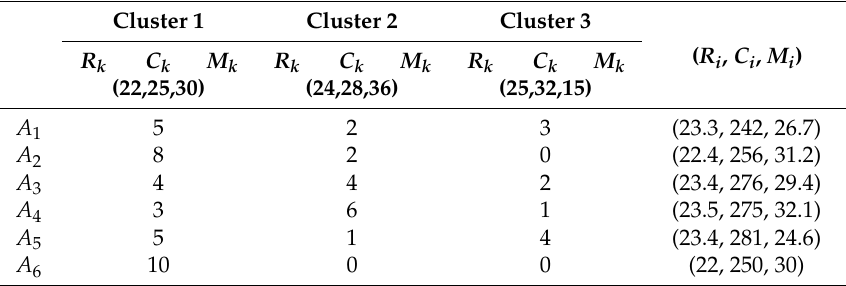
Table 2. Example of Cluster Selection